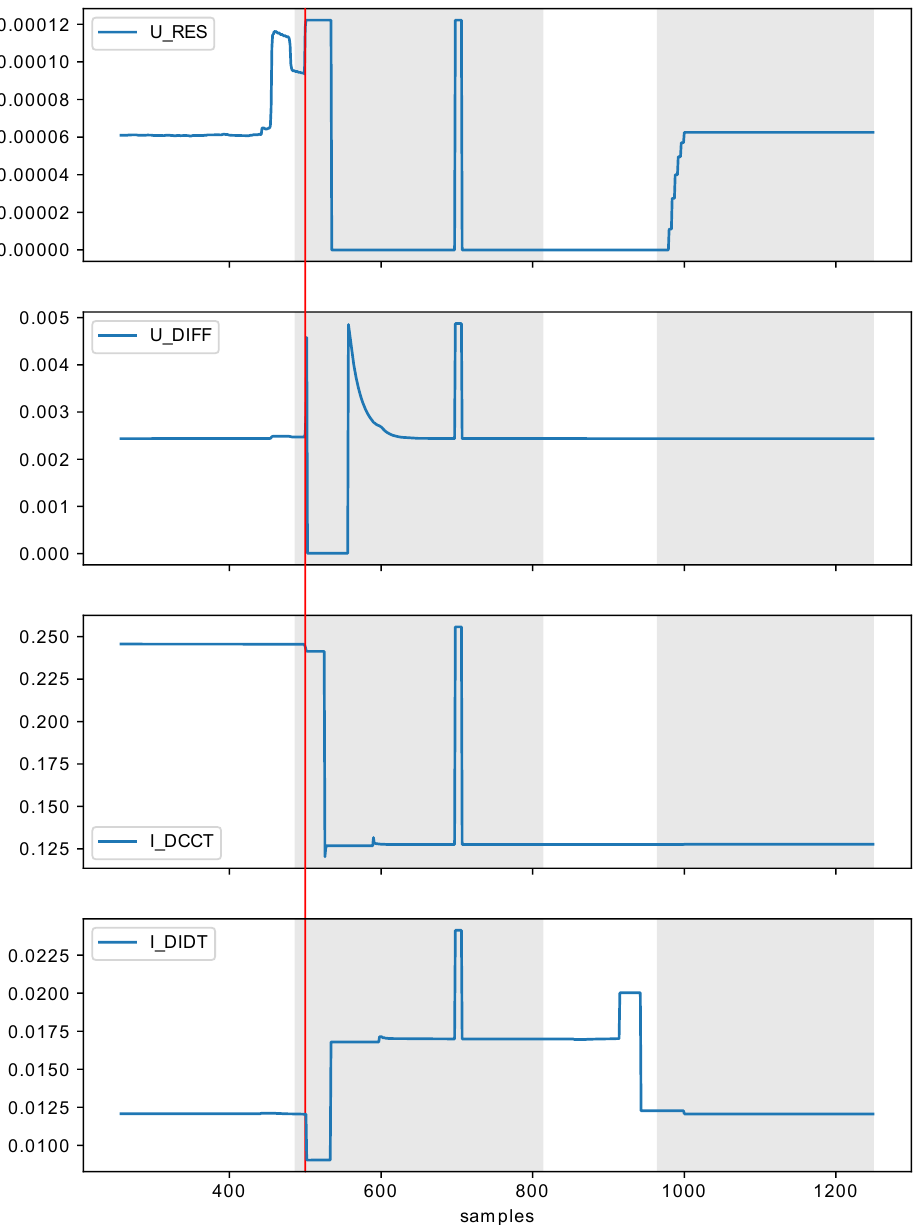
Figure 9. Example single series results visualization ( in _ grid = 32, in _ algorithm = adaptive , look _ back = 256). Red line across all subplots marks the QUENCHTIME and gray spans indicate the anomalies found by the